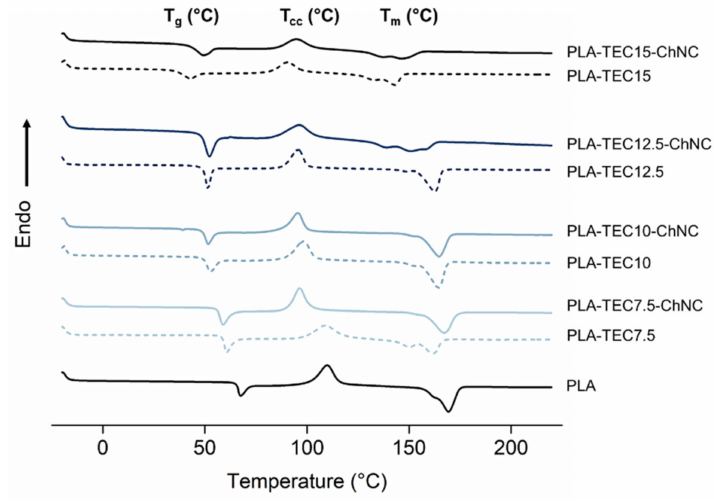
Figure 6. DSC thermograms of PLA-TEC films and their nanocomposites showing the effect of ChCNs on the thermal properties of the nanocomposites.